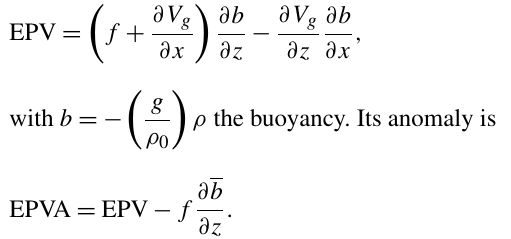
Figure 3. Maps of the MADT (altimetric) anomaly averaged over a month, from November 2010 to June 2011. Anticyclone A1 formed and remained in the eastern Sea of Oman from December 2010 to April 2011; anticyclone A2 formed from the coastal “belt” along the Omani coast in February 2011, intensifying during summer 2011; anticyclone A3 split from A1 in March 2011 and remained at the mouth of the Sea of Oman; cyclone C1 formed and remained off Ra’s Al Hadd in late 2010, intensifying until February 2011; cy- clone C2 formed in late 2011 and drifted